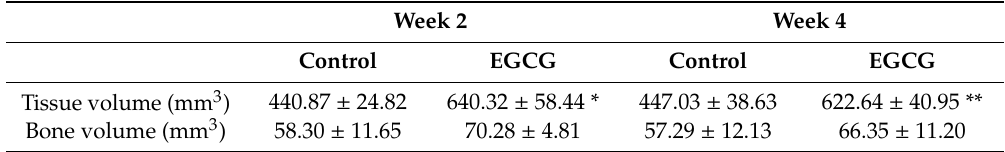
Table 1. The quantification results of callus in µ -CT.